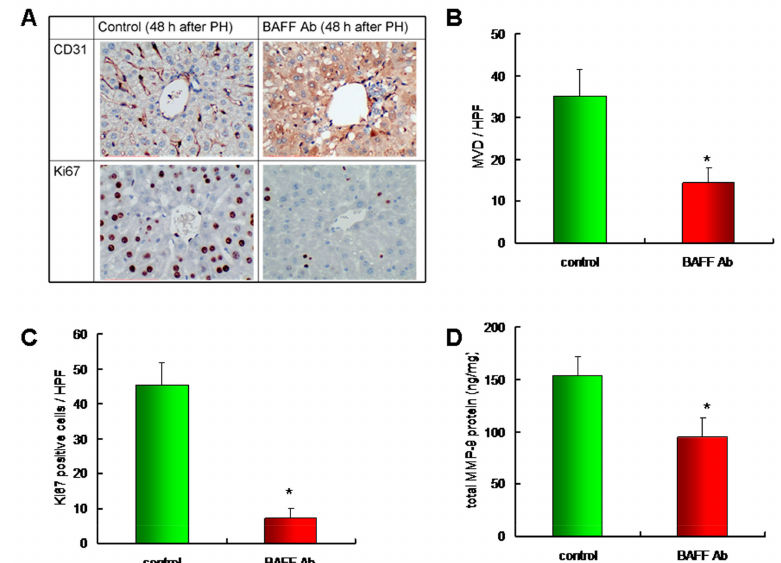
Figure5. Microvesseldensity,cellproliferation,andMMP-9expressioninlivertissueofBAFF-neutralizing antibodies treated mice. ( A ) Mice were injected intraperitoneally with 100 µ g control IgG or anti-mouse BAFF-neutralizing antibodies after 70% partial hepatectomy. After 48 h, mice were sacrificed, and the remaining liver tissues were dissected and stained for CD31 and Ki67. Magnification, 400 × . ( B ) Quantitative results of microvessel density in remaining liver tissue, n = 10 per group. * p < 0.05, by Student’s t -test. ( C ) Quantitative results of Ki67 positive staining cells in remaining liver tissue, n = 10 per group. * p < 0.05, by Student’s t -test. ( D ) MMP-9 protein level in remaining liver tissue was determined by EIA, n = 10 per group. * p < 0.05, by Student’s t -test.